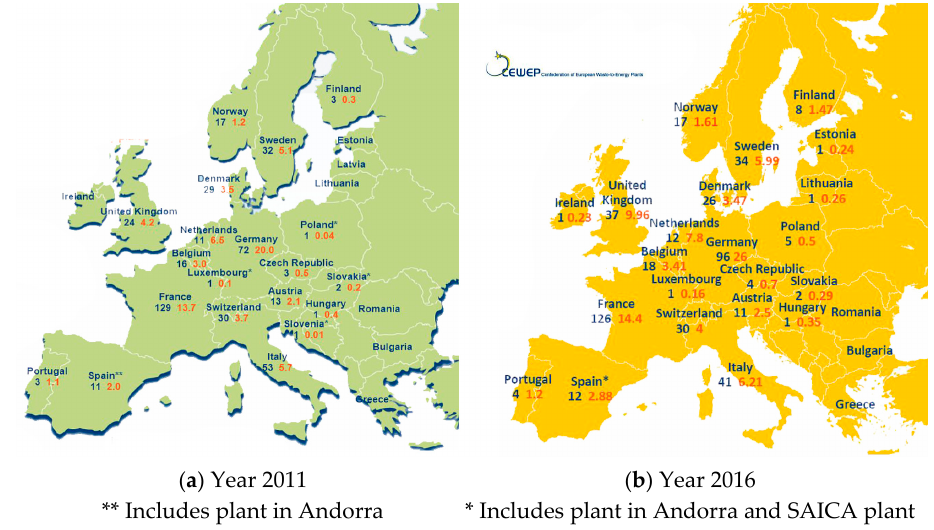
Figure 2. Cartograph demonstration—energy recovery operations in the EU in 2011 and 2016. Using a scatter chart, the indicator results were compared across countries by year. Recent periods are highlighted with black dots, making it possible to assess the trends of individual countries, as shown in the graph below (Figure